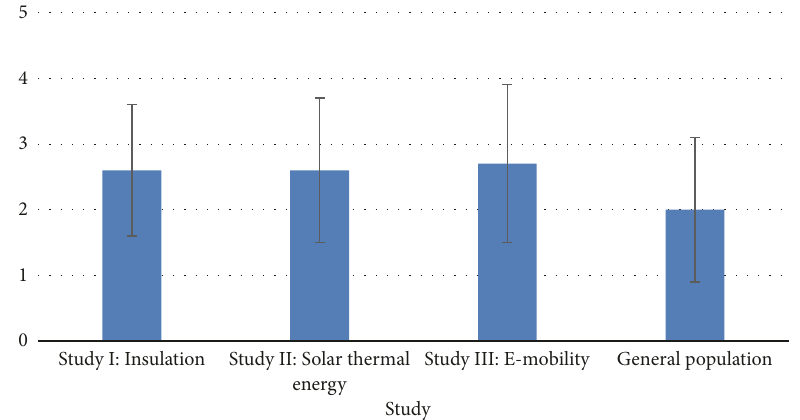
Figure 4: Number of household members (means and standard deviations) of the samples in comparison to the basic population of German